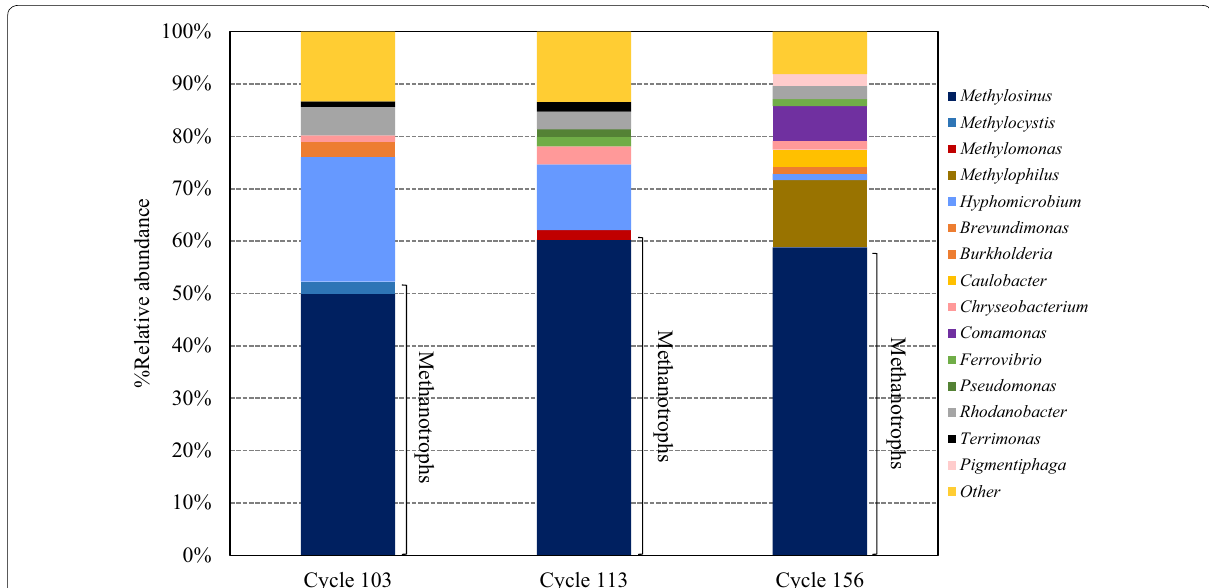
Fig. 2 Relative abundance of bacterial 16s rRNA genes at the genus level. The relative abundance of each bacterial 16s rRNA expressed as % of OTUs in the sample that were present at more than